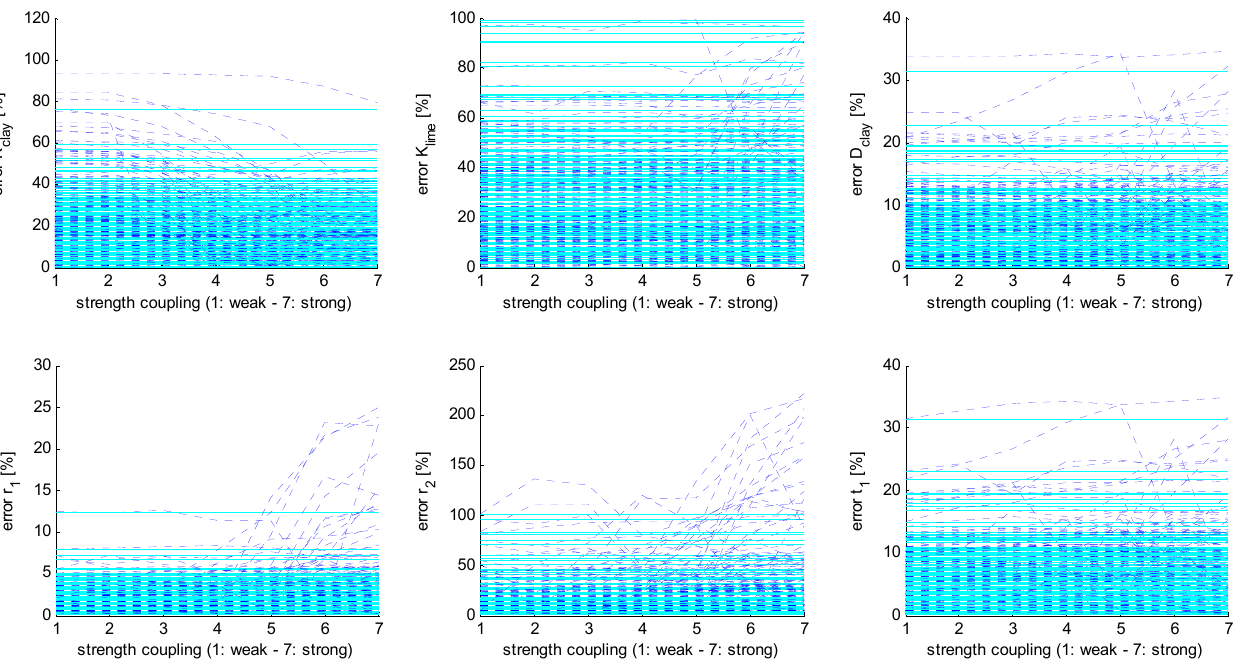
Fig. 5. Error parameter estimates for the second configuration of JHI and SHI runs using 250 parameter realizations and larger e corr for the generated “true” parameters. Blue dashed lines indicate parameter errors for JHI Runs 1–7, where the cyan lines indicate the parameter errors for the SHI.